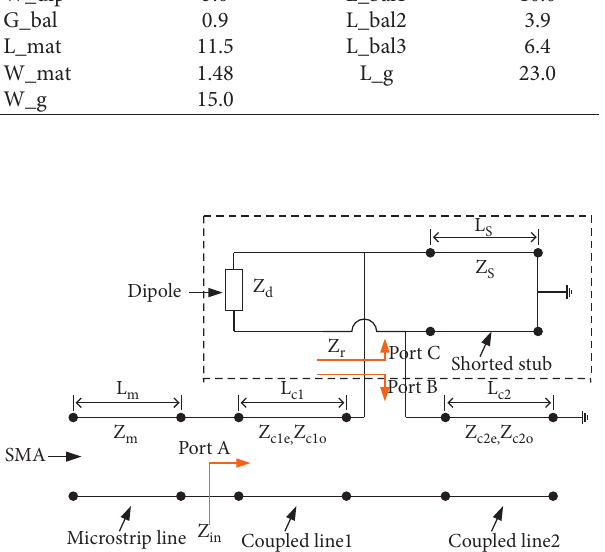
Figure 3: Equivalent circuit of the printed dipole with the